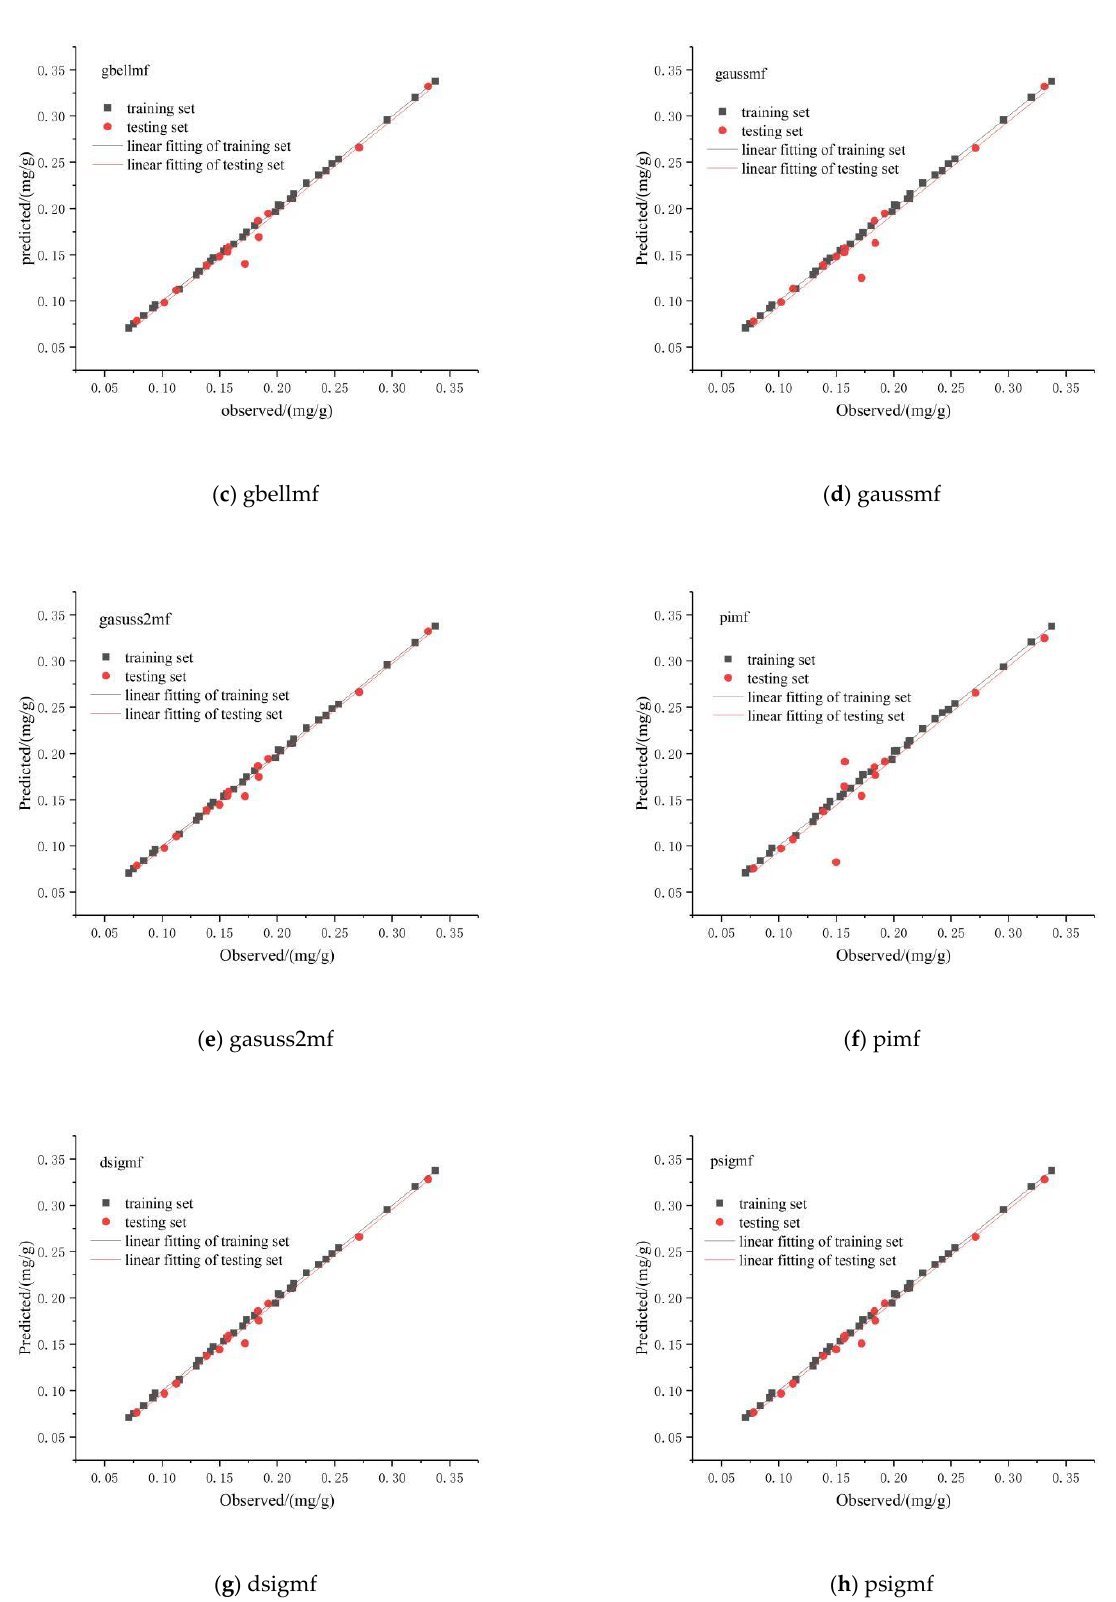
Figure 5. Correlations between the observed and predicted chlorophyll contents in the pericarp of fragrant pears during storage using the adaptive neural fuzzy inference system (ANFIS) model with different membership functions (MFs) in the training and prediction stages.